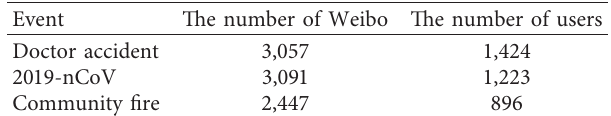
Table 2: Empirical study